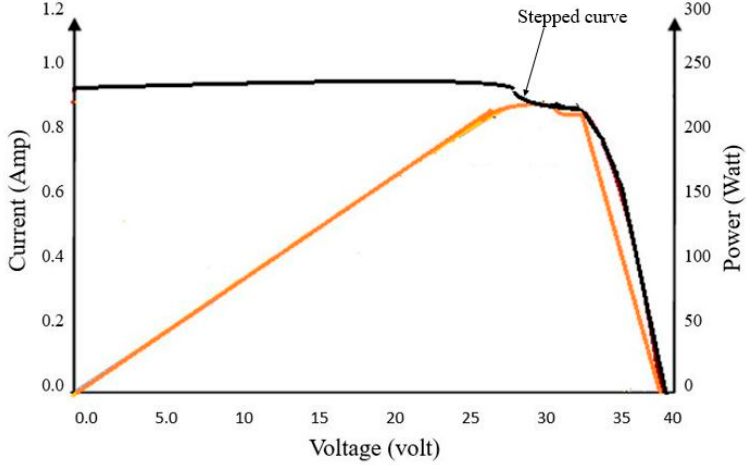
Figure 1. Step curve due to shading.